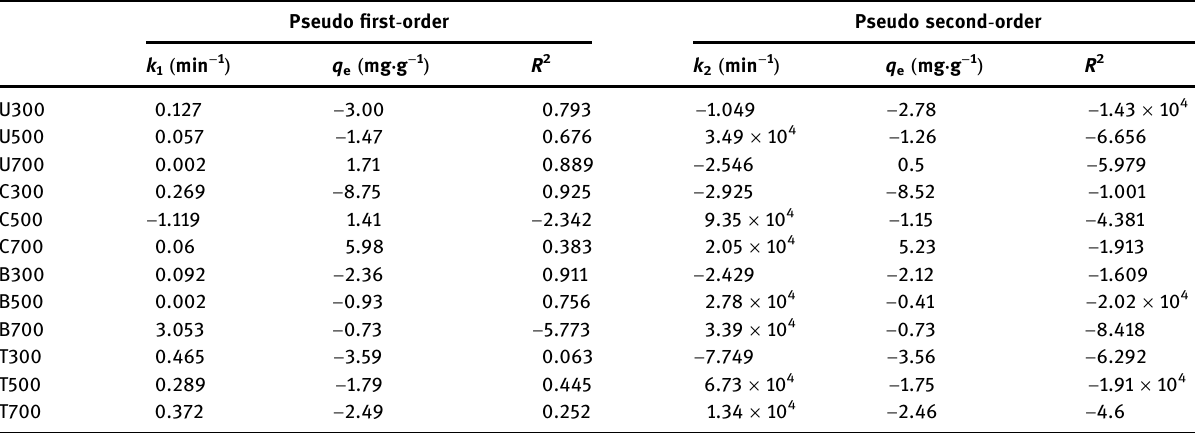
Table 2: Pseudo fi rst - order and pseudo second - order kinetic fi tting parameters Pseudo fi rst - order Pseudo second - order